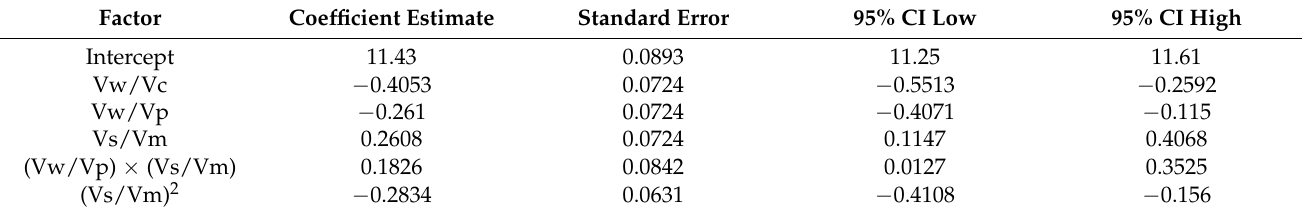
Table 10. F,24 h model coefficients in terms of coded